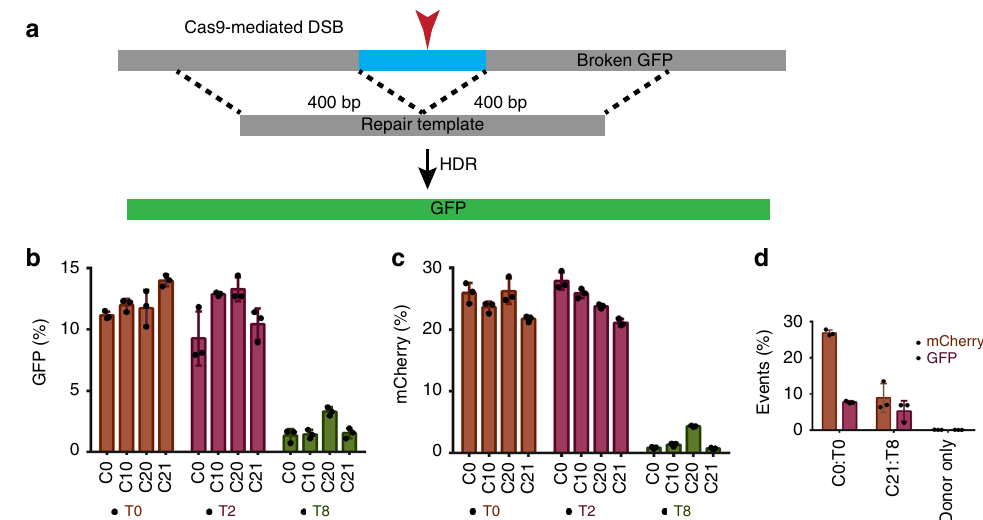
Fig. 5 Heavily and fully modi fi ed RNAs support precise genome editing. a Schematic of the Cas9-mediated homology-directed repair in HEK293T-TLR cells. Cells were electroporated with 20 pmoles of Cas9 RNP and 400ng of 800 bp donor (PCR fragment). Precise repair of the DSB results in GFP expression ( b ), and NHEJ-mediated + 1 frameshifts result in mCherry expression ( c ). d The fully modi fi ed C21 : T8 dual guides were tested using 100 pmoles of Cas9 RNP to test whether fully modi fi ed RNAs recover HDR activity at higher doses. Bars show averages (±SD) of three biological